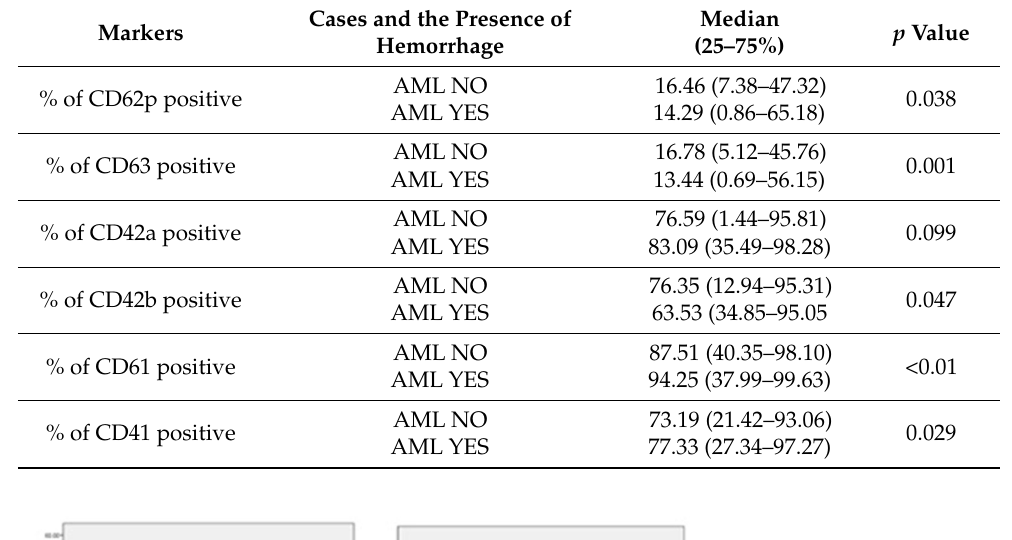
Table 4. The medians and 25th–75th percentiles were used to appreciate and compare distributions in both groups (Figure 4). The median age was closely similar in both groups: 46 and 43 years old. Table 4. Platelets’ antigens distribution in AML patients with or without bleeding.